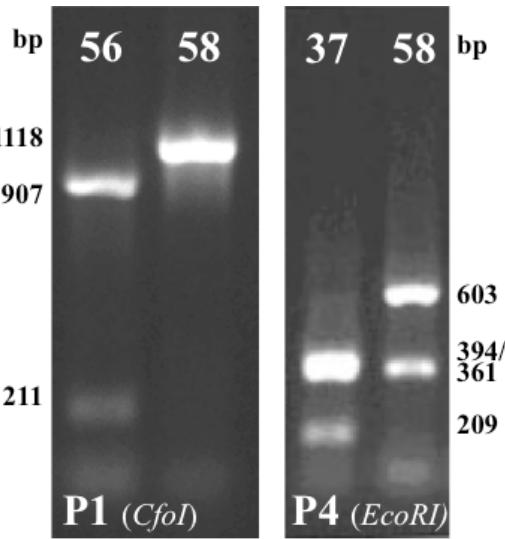
Figure 2. Digestion patterns of Phytophthora infestans mtD- NA polymorphic regions P1 and P4. Comparison of iso- lates 37_LE, and 56_BO (Ia haplotype) with isolate 58_BL (IIb haplotype). The digestion product length, in base pair, is indicated on each